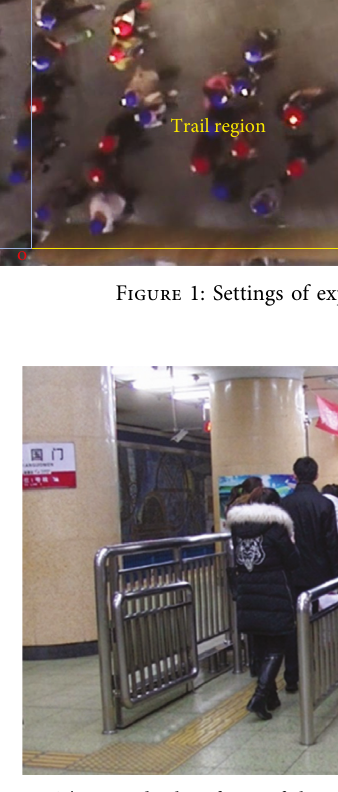
Figure 2: The guardrail in front of the escalator in Beijing subway